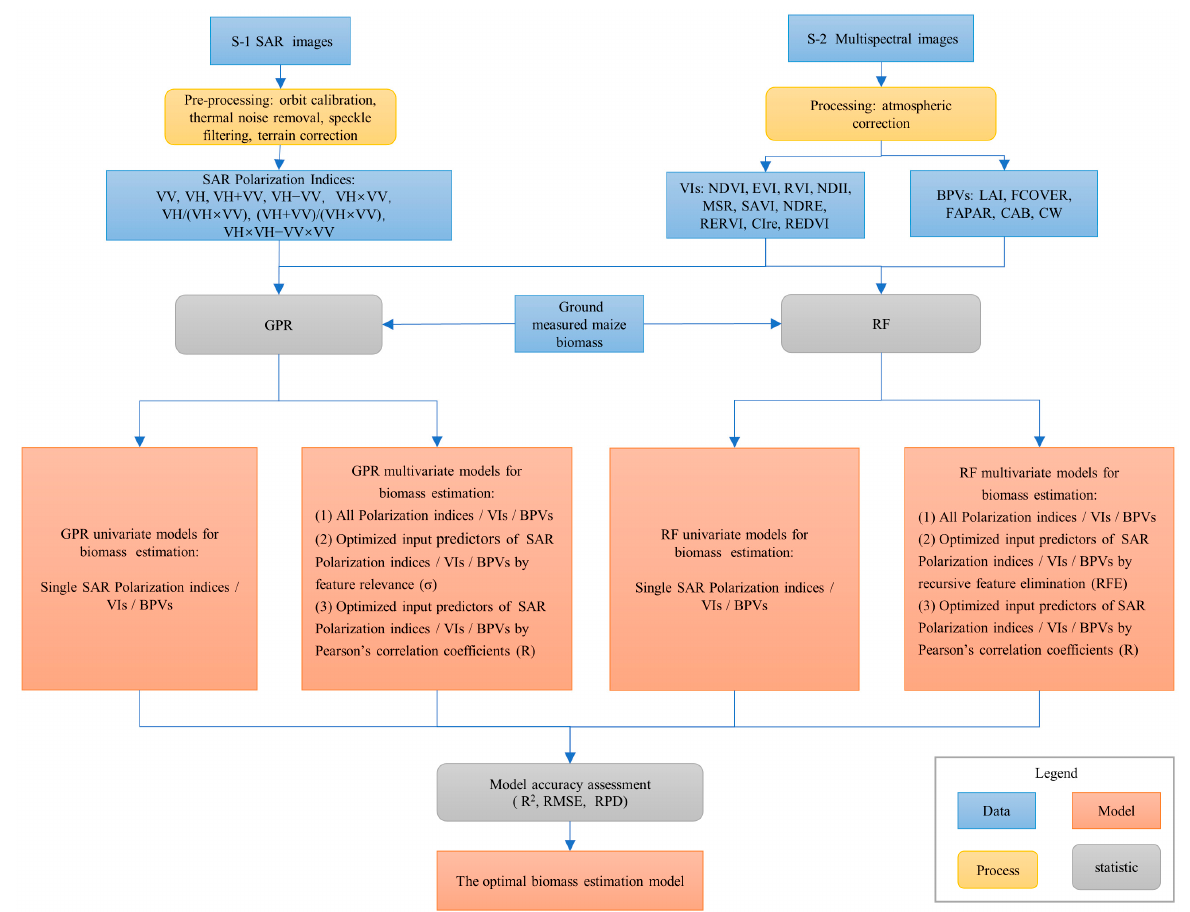
Figure 2. Flowchart for maize biomass estimation from S-1 and S-2 data.